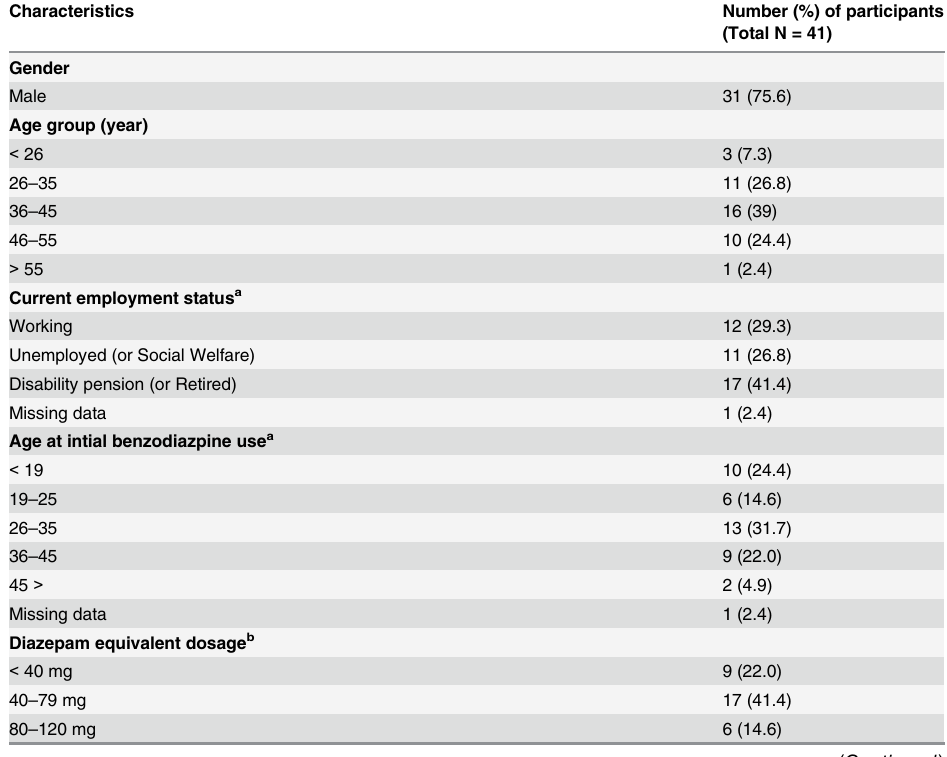
Table 2. Participants ’ demographic characteristics, benzodiazepine consumption patterns and psy- chiatric comorbidities.